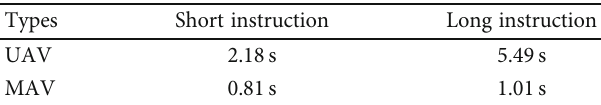
Figure 2: UAV communication lag-time. Table 1: Controller response lag-time by using self-rating